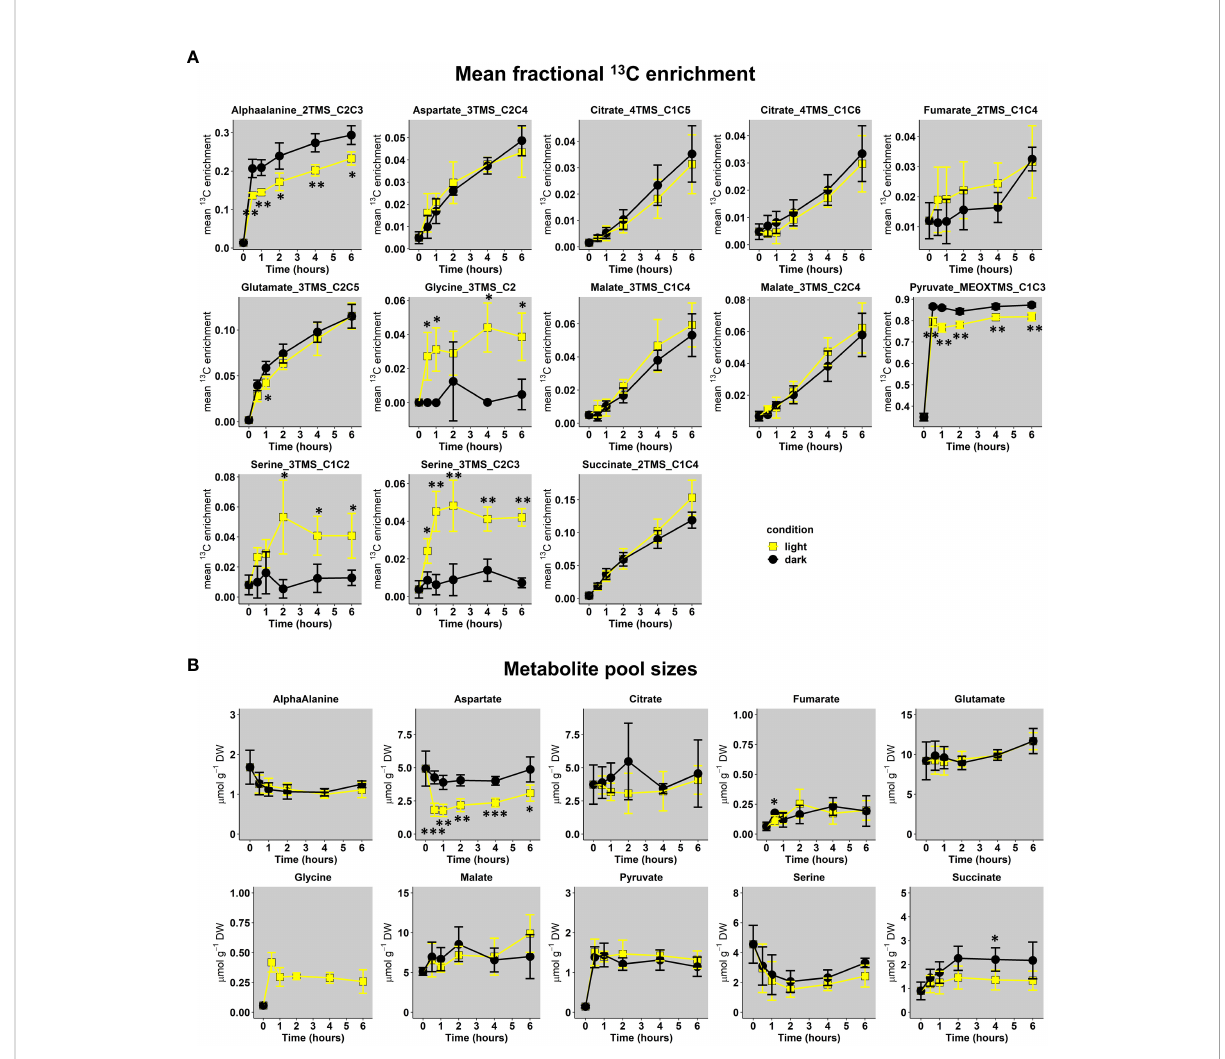
FIGURE 4 Dynamics of U- 13 C-pyruvate incorporation in Brassica napus leaf discs exposed to light or dark conditions. (A) , Mean fractional 13 C enrichment and (B) , Metabolite pool sizes. Mean fractional 13 C enrichment were monitored with GC-MS, while absolute quanti fi cation of organic and amino acids was performed respectively with GC-FID and HPLC-UV. The results are presented as the mean ± SD of four independent biological replicates. Statistical differences between dark and light conditions are denoted with asterisks according to a Student test (*, p-value<0.05; **, p-value<0.01; ***, p-value<0.001). The complete dataset is available in Tables S2, S3. Supplementary statistics (ANOVA and post-hoc Tukey- HSD tests) are available in Tables S4,